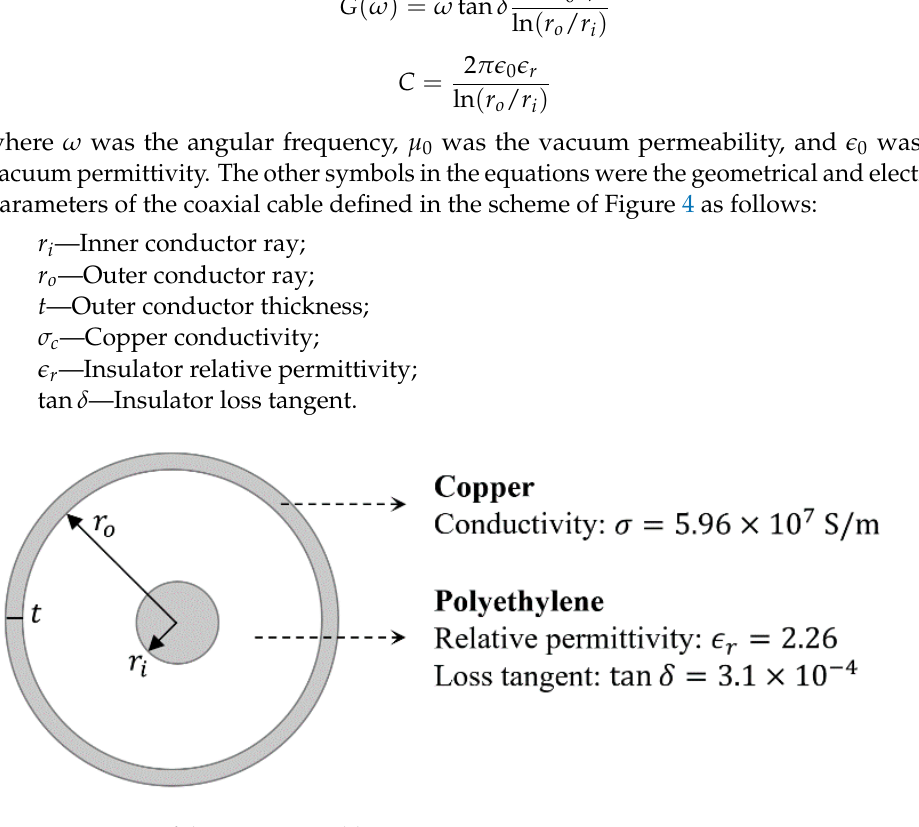
Figure 4. Section of the RG58-CU cable. The effectiveness of the TL model in representing the coaxial cable was evaluated by comparing simulated TDR signals with experimental signals measured in the same configurations. As can be seen in Figure 5, the theoretical model was not able to accurately represent the cable. In particular, the differences in the shape of the reflected signals indicate poor modeling of the frequency-domain behavior of the coaxial